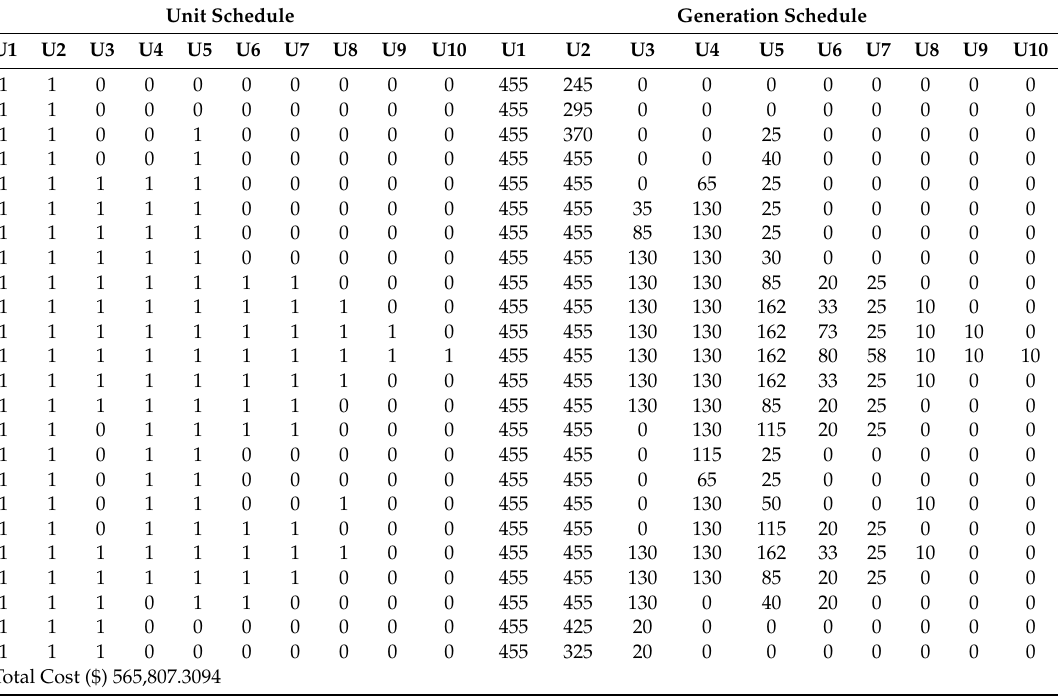
Table 11. Commitment and generation schedule of the 10-unit system by